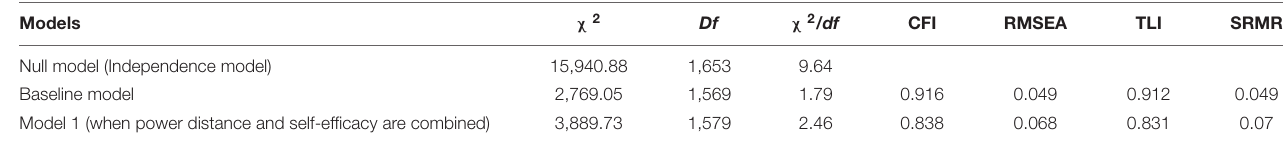
TABLE 2 | Measurement models comparison of